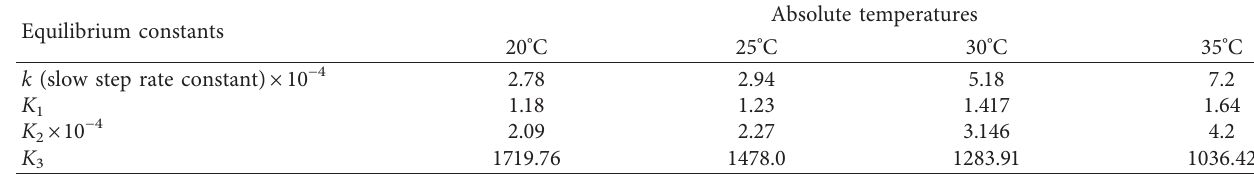
Table 4: Equilibrium constants and slow step rate constant for